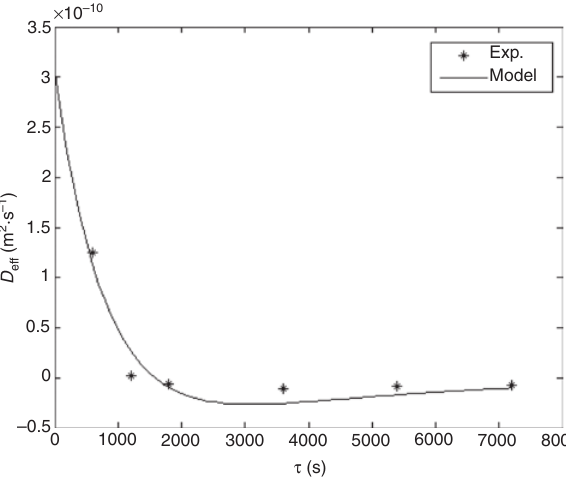
Figure 4: Dependence of concentration on time at t = 20 ° C; ζ = 0.04 m 3 /kg and solvent water for System II.